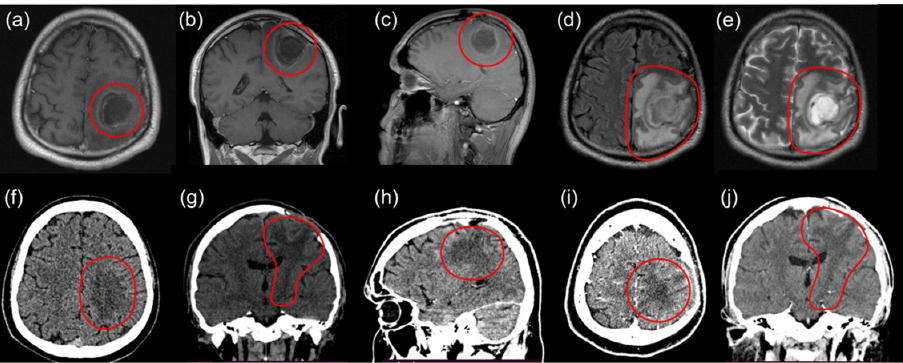
Figure 4. MRI images before third surgery: T1 axial ( a ), coronal ( b ), and sagittal ( c ) projections with contrast enhancement; T2 flair axial ( d ) and T2 axial ( e ) projections. CT images 2 months after third surgery: axial ( f ) and coronal ( g ) views. Ischemia of the left parietal lobe. CT images with contrast enhancement 2 months after third surgery: sagittal ( h ), axial ( i ), and coronal ( j ) views. No recurrent tumor and no contrast uptake in the tumor bed.